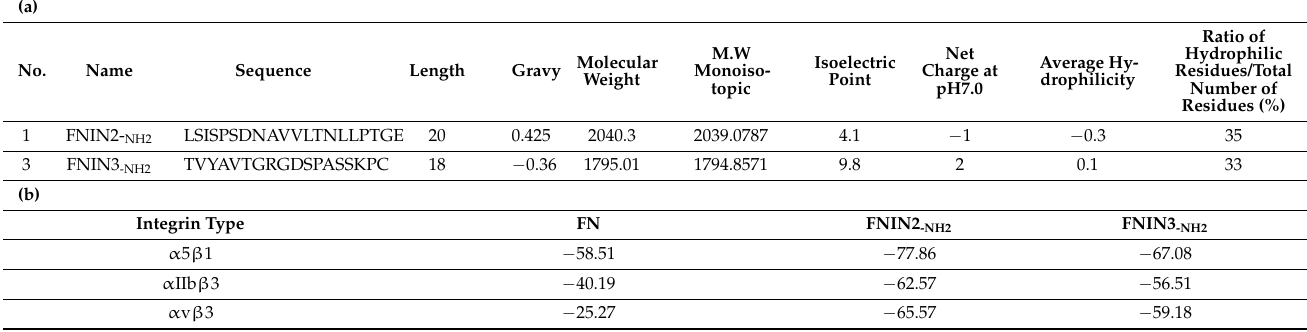
Table 1. General properties of fibronectin-based intergrin binding peptides (FNINs) and their binding efficacies with integrins. a. Physicochemical properties of peptides. b. Binding efficacies (global energies) of integrin inactions with FN and designed